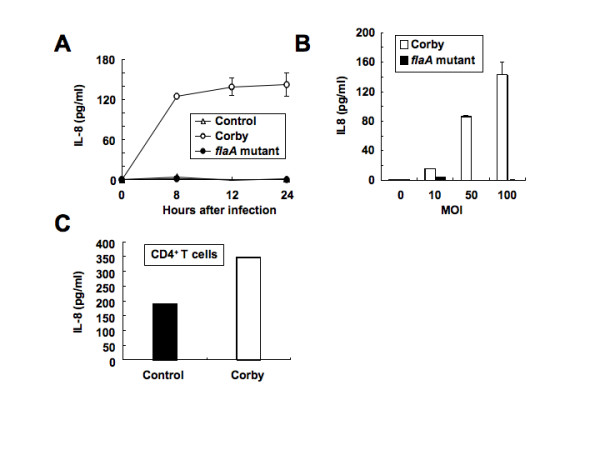
IL-8 production from Jurkat cells during infection with L. pneumophila strains. (A) Jurkat cells were infected with the indicated L. pneumophila strains at an MOI of 100 for the indicated time periods. (B) Jurkat cells were infected with the varying concentrations of the indicated L. pneumophila strains for 24 h. (C) CD4+ T cells were infected without or with Corby for 3 h. IL-8 concentrations in the supernatants were determined by ELISA. Data are mean ± SD values collected in three experiments.